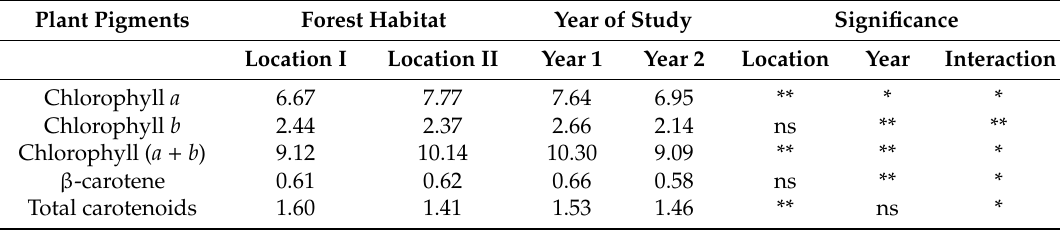
Table 5. Results of two-way ANOVA between stands location and year of study on chlorophyll